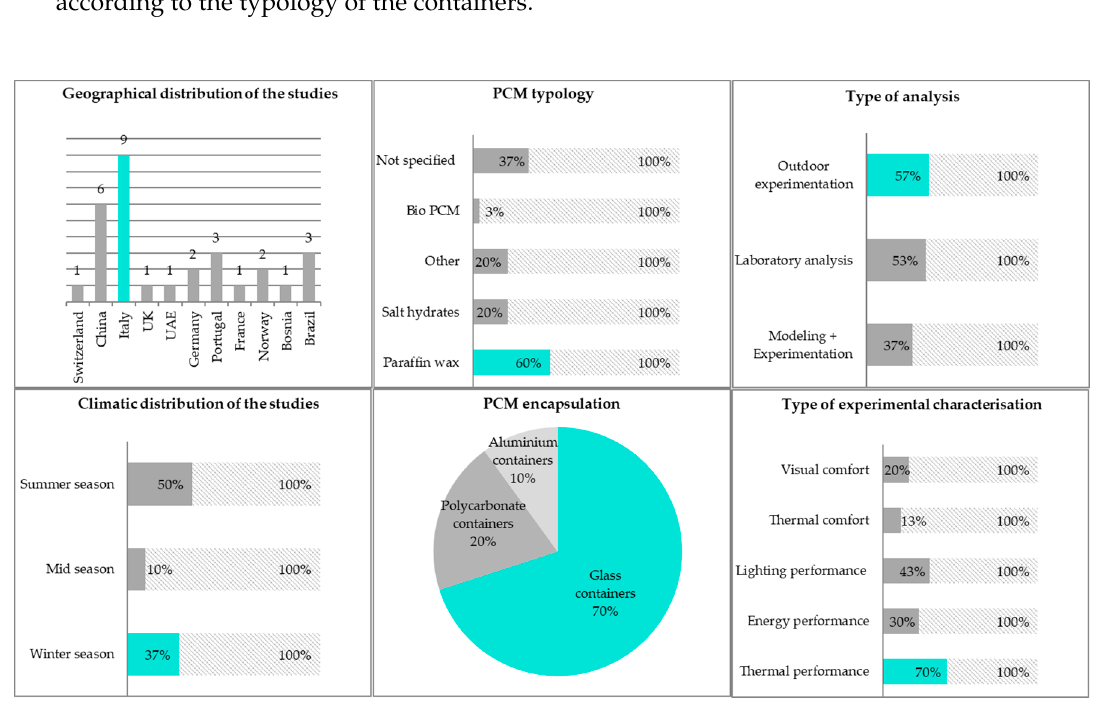
Figure 1. Analysis of the papers that presented experimental activities on PCM glazing systems .